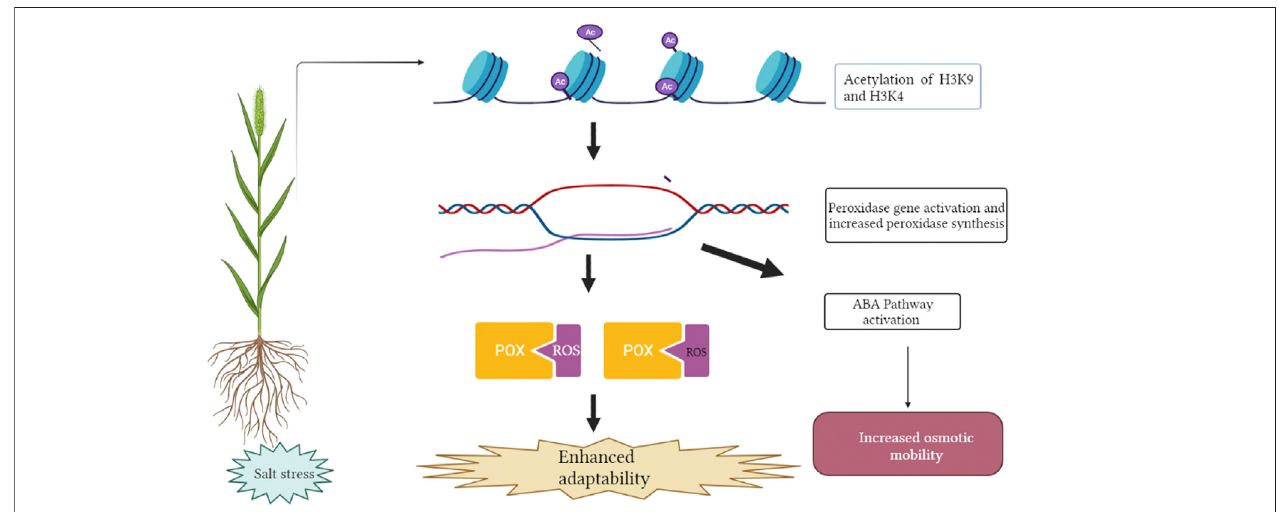
FIGURE 3 | Deposition of acetylation at H3K4 and H3K9 position leads to activation of salt responsive POX gene encoding peroxidase enzyme. Increased expression of peroxidase gene has been associated with activation of the ABA pathway (Absicsic acid) and antioxidant enzymes, resulting in lower ROS (Reactive Oxygen Species) accumulation and increased levels of osmotic metabolites. This fi gure was created using